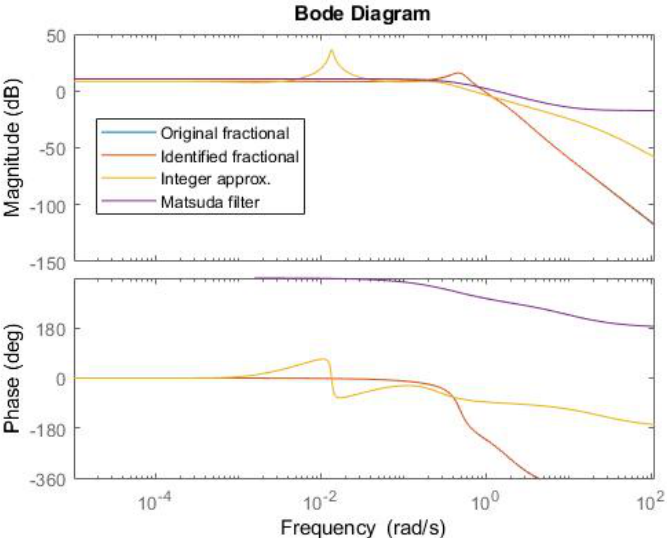
Figure 18. Comparison of Bode diagrams for the integer order approximation and Matsuda’s